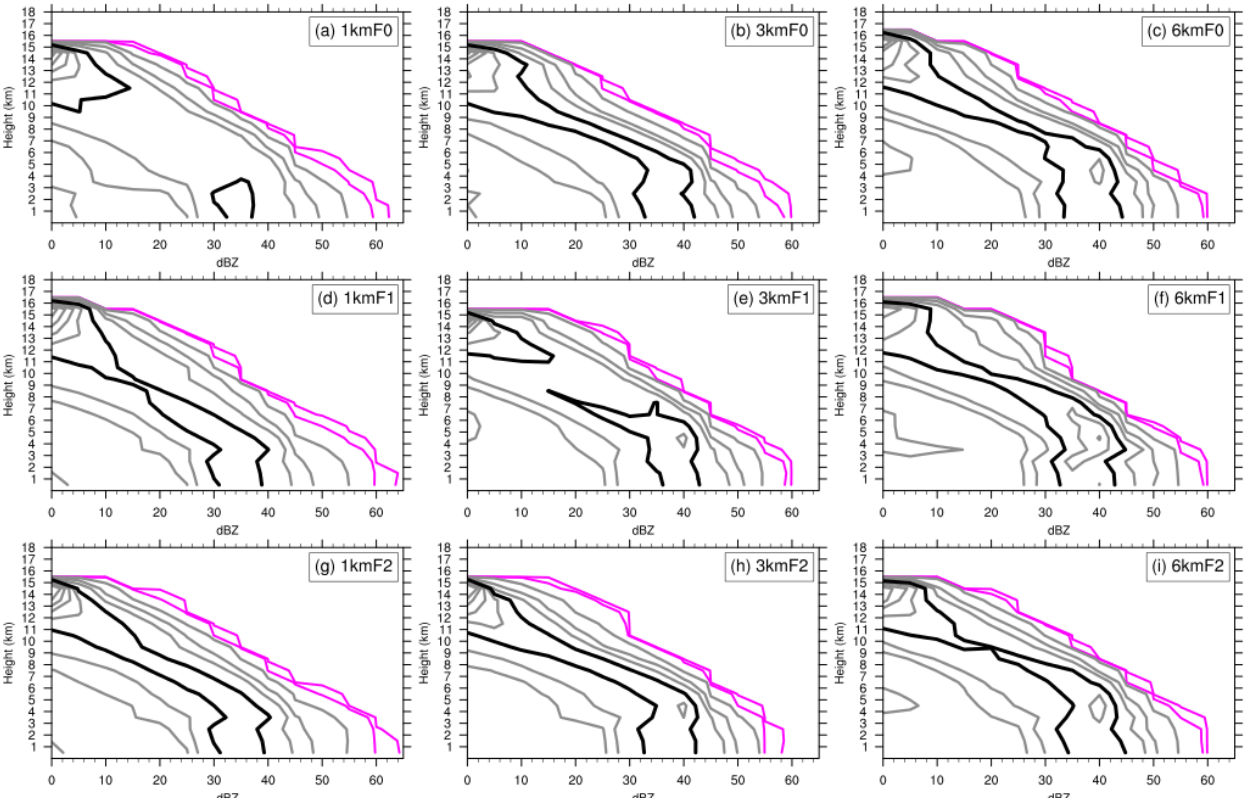
Figure 13. The CFADs of simulated reflectivity for experiments (a) 1kmF0, (b) 3kmF0, (c) 6kmF0, (d) 1kmF1, (e) 3kmF1, (f) 6kmF1, (g) 1kmF2, (h) 3kmF2, and (i) 6kmF2. The sampling time for model output is taken as the simulated typhoon centered at its nearest location to the best-track location at 18:00UTC on 7 November 2013 and for the following 2h. The simulated reflectivity was taken from all grid points with updraft (positive vertical velocity) within the calculation domain for CFADs (see blue box in Fig. 3 for the corresponding area) in the model native grids. For reflectivity CFADs, the bin size is 5dBZ and the plot is contoured at 0.01%, 0.1%, 1%, 5%, 10%, 20%, 30%, 40%, 50%, and 60% of data per decibel relative to Z per kilometer (%dBZ − 1 km − 1 ), with the 20%dBZ − 1 km − 1 contour highlighted in black and the lowest two contours displayed in